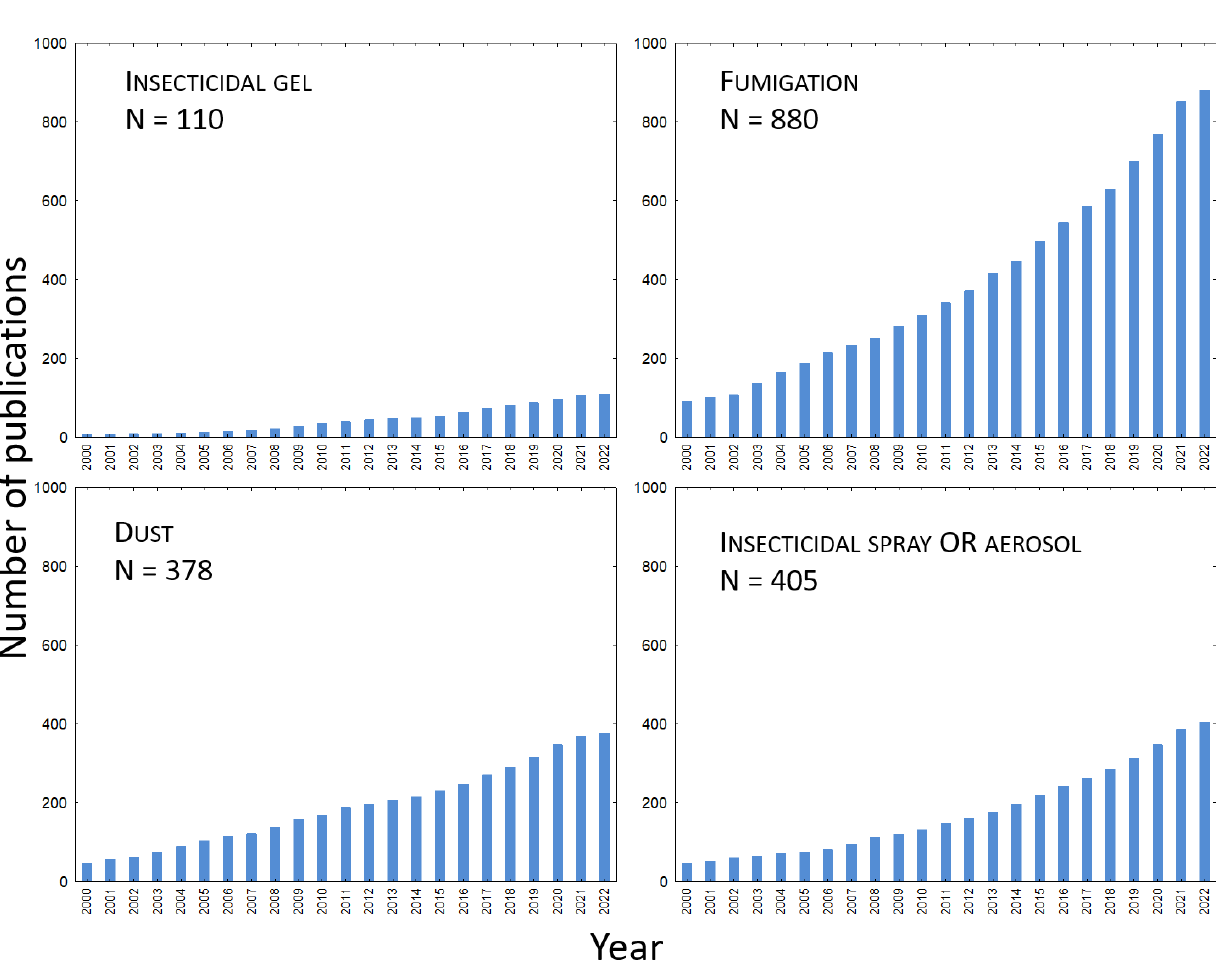
Figure 2. Comparison of cumulative number of WoS peer-reviewed scientific publications from 2000 to the present on the topic of gels and other pesticide formulations (solid dusts, gas-fumigants, liquid sprays) regarding their use for pest control.